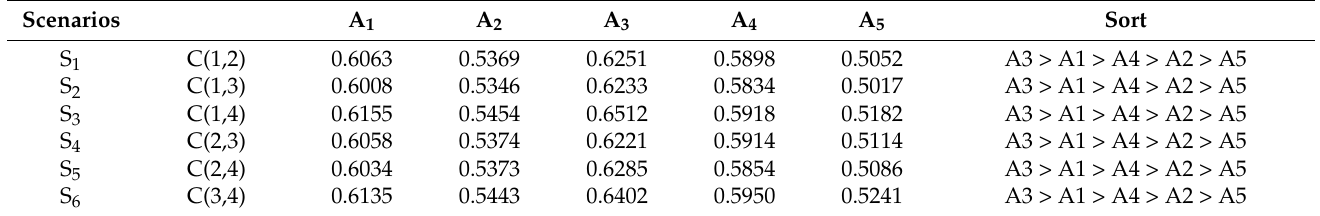
Table 12. Sensitivity rankings of Table 11. Sensitivity rankings of Q i .